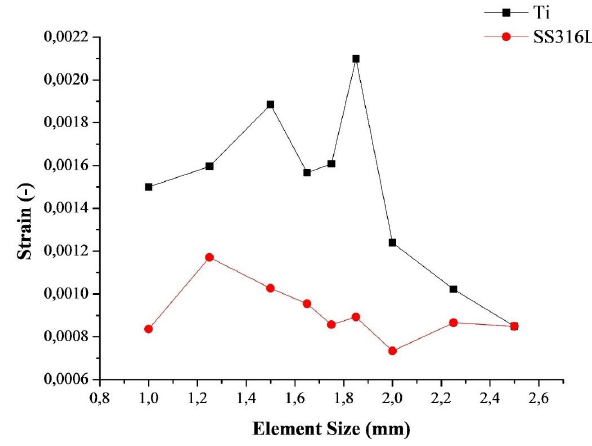
Figure 8: Graph of relationship between element size and strain